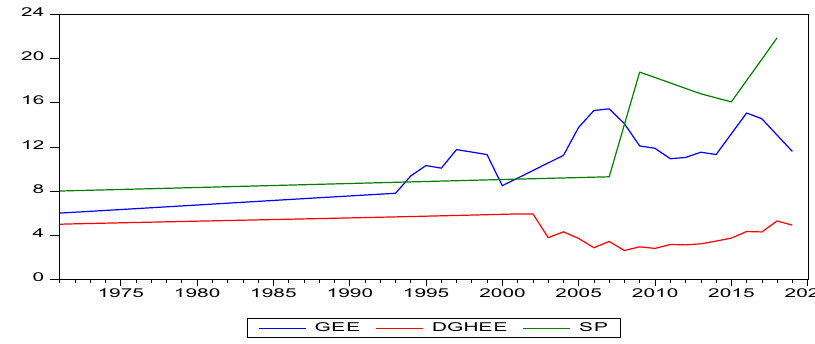
Fig. 1 Government expenditure trends. Government spendings on education, health, and